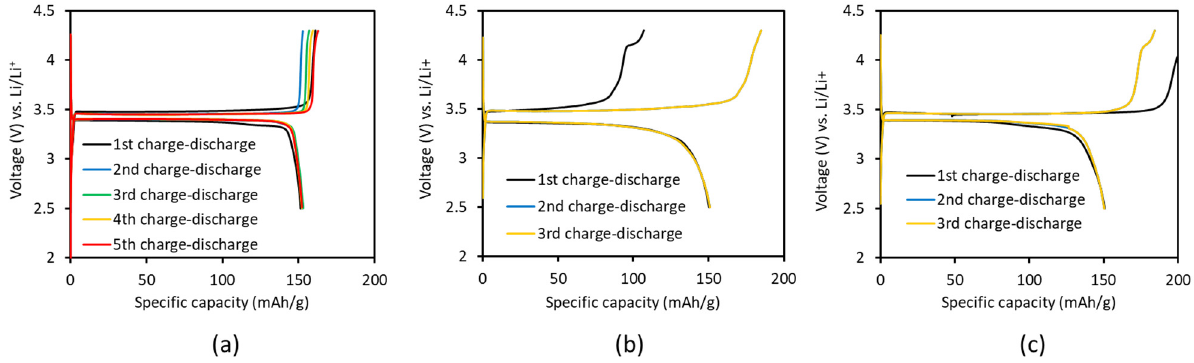
Figure 8. GCD test plots at 0.05 C for Li-LFP battery cells. Cathodes: ( a ) PVDF binder; ( b ) KynarFlex ® PVDF 2801-00 binder; ( c ) Kynar PowerFlex ® LBG binder.